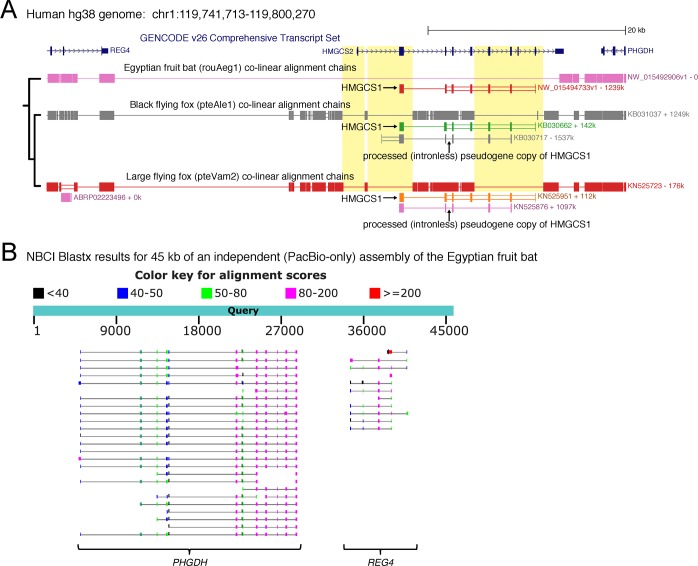
Large deletions in the HMGCS2 locus in pteropodid fruit bats.(A) Screenshot of the human UCSC genome browser shows the HMGCS2 locus with its flanking genes and co-linear pairwise alignment chains to three pteropodid bats. Chains that align the paralog HMGCS1 or a processed HMGCS1 pseudogene in flying foxes are labeled. Please note that we show in this figure the transcript ENST00000369406, which includes an alternative exon three that is skipped in the transcript shown in Figure 1B (ENST00000544913). Yellow background highlights the deletion of exon 1, a separate deletion that removed exon 2 (shown in detail in the inset in Figure 1B) and a deletion that removed four consecutive exons downstream. At least the second deletion exhibits shared breakpoints between both flying foxes, showing that loss of HMGCS2 already occurred in the ancestor of both species. The phylogenetic relationships of the three species are indicated on the left side. (B) To validate the deletion of HMGCS2 in the Egyptian fruit bat, we used an independent PacBio assembly. The locus around the neighboring PHGDH and REG4 gene is covered by several large PacBio reads. Blastx results only reveal the presence of PHGDH and REG4 but no evidence of HMGCS2. Consistent with HMGCS2 deletion, the PHGDH and REG4 are separated by ~ 50 kb in human but only ~ 6 kb in the Egyptian fruit bat.